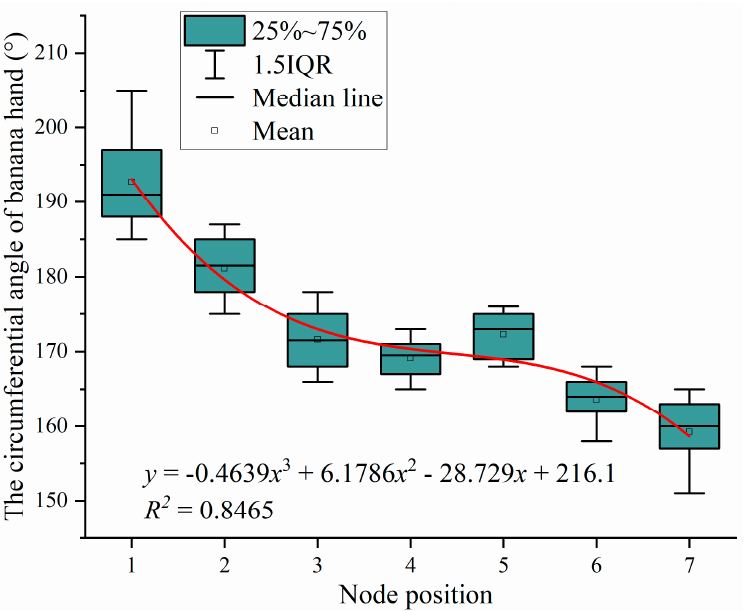
Figure 20. The relationship between the circumferential angle of the banana hand and the node position.